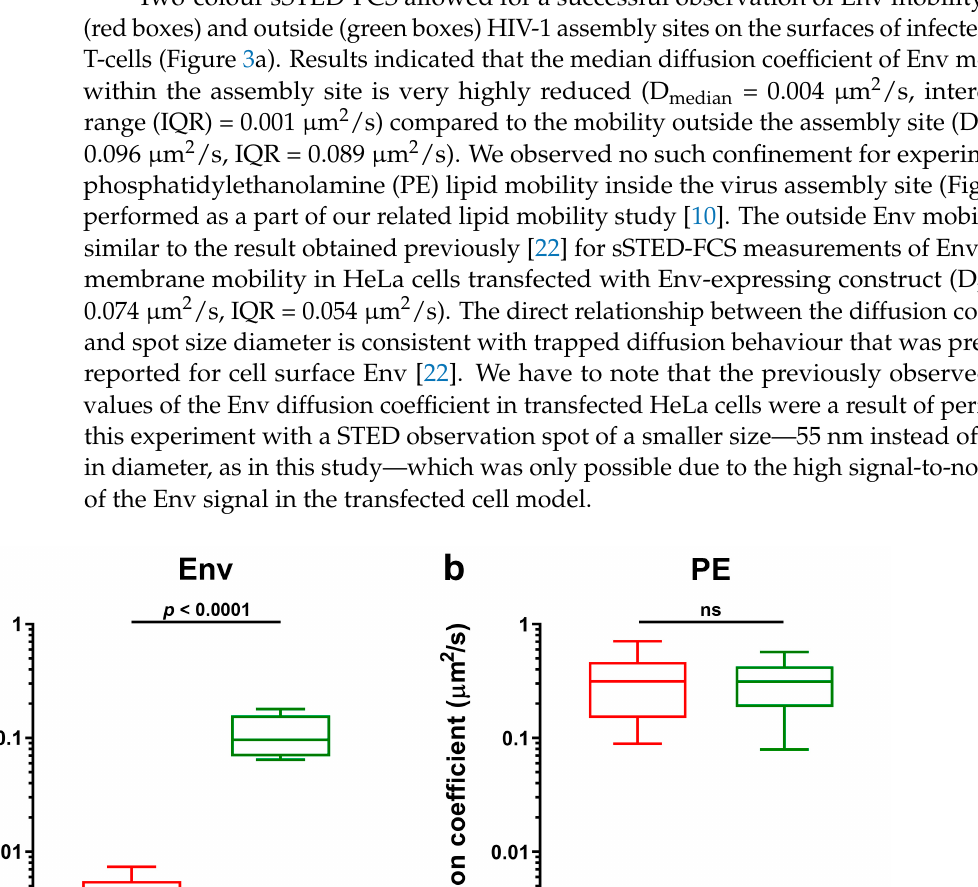
and y-axis correspond to the position on the scan line and signal intensity at each time point, respectively. Scale bars: x-axis (white) = 200 nm, y-axis (grey) = 2.08 ms. ( f ) Representative normalised autocorrelation curves of Env diffusion from inside (light grey) and outside (dark grey) the virus assembly site obtained from a single position on the scan line within correlation carpets (marked by the asterisk (*) and plus sign (+), respectively, in c – e ). Env signal autocorrelation curves for inside and outside virus assembly site (red and blue, respectively) were fitted using two-dimensional diffusion model. Greyed out area corresponds to the photobleaching-only portion of the correlation data.